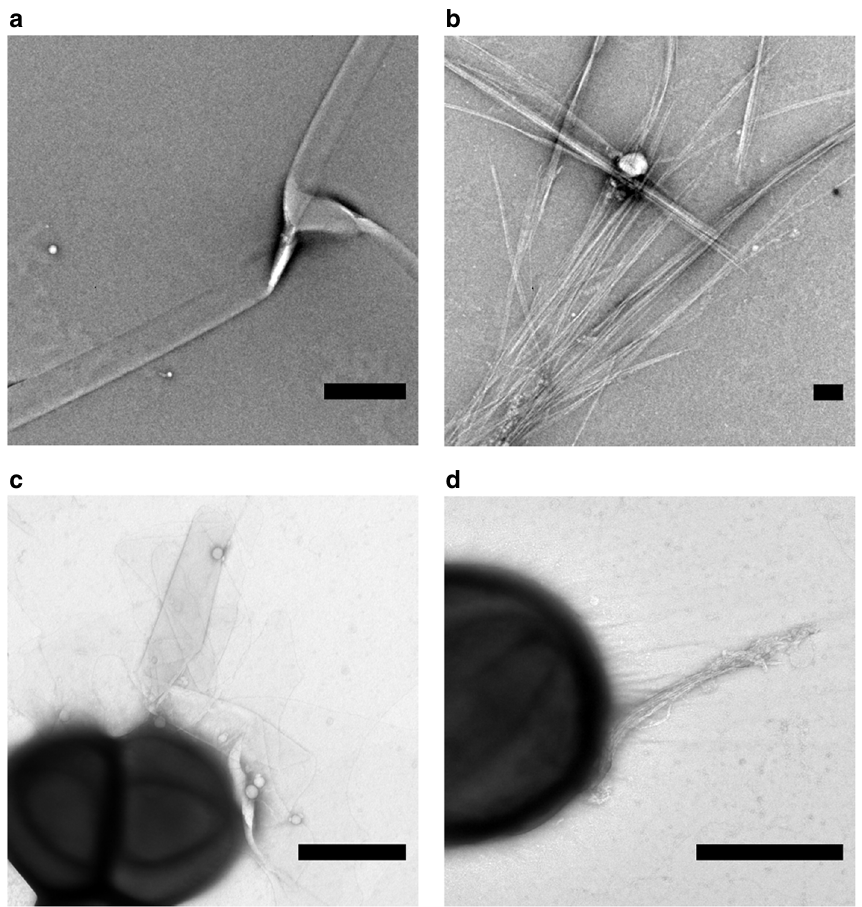
Fig. 2 Human and gorilla LL-37 17-29 fi brillar assemblies and interactions with bacteria. a An electron micrograph of 1 mM hLL-37 17-29 incubated for three days. b An electron micrograph of 1 mM gLL-37 17-29 incubated for 3 days. c An electron micrograph of 30 µ M hLL-37 17-29 (close to the MIC concentration of 22 µ M) incubated with M. luteus for 4 h. d An electron micrograph of 60 µ M gLL-37 17-29 (close to the MIC concentration of 53 µ M), incubated with M. luteus for 4 h. All scale bars represent 500